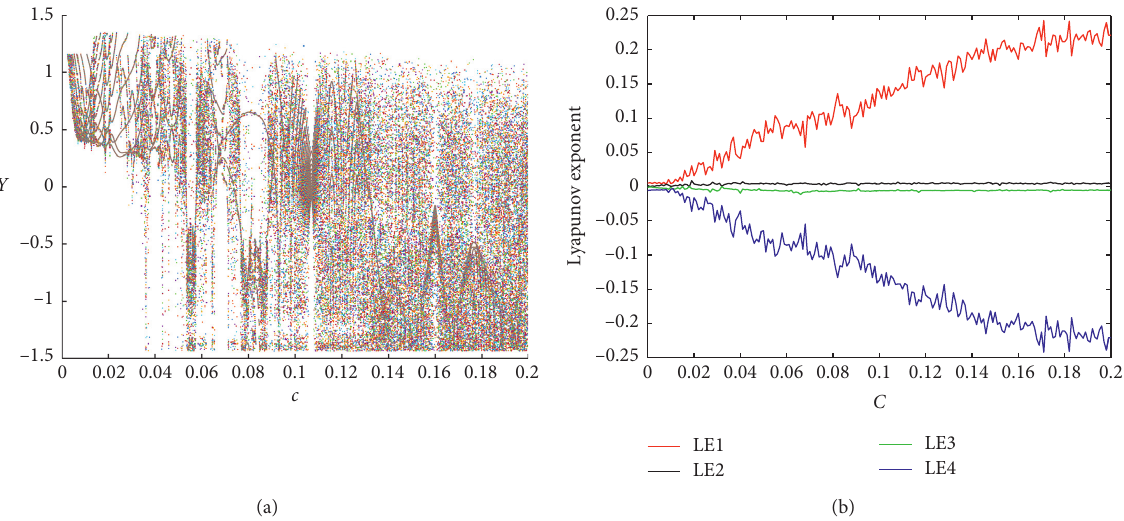
Figure 5: Lyapunov exponent spectrum and bifurcation diagram of Case 1 system versus c . (a) Bifurcation diagram. (b) Lyapunov exponent